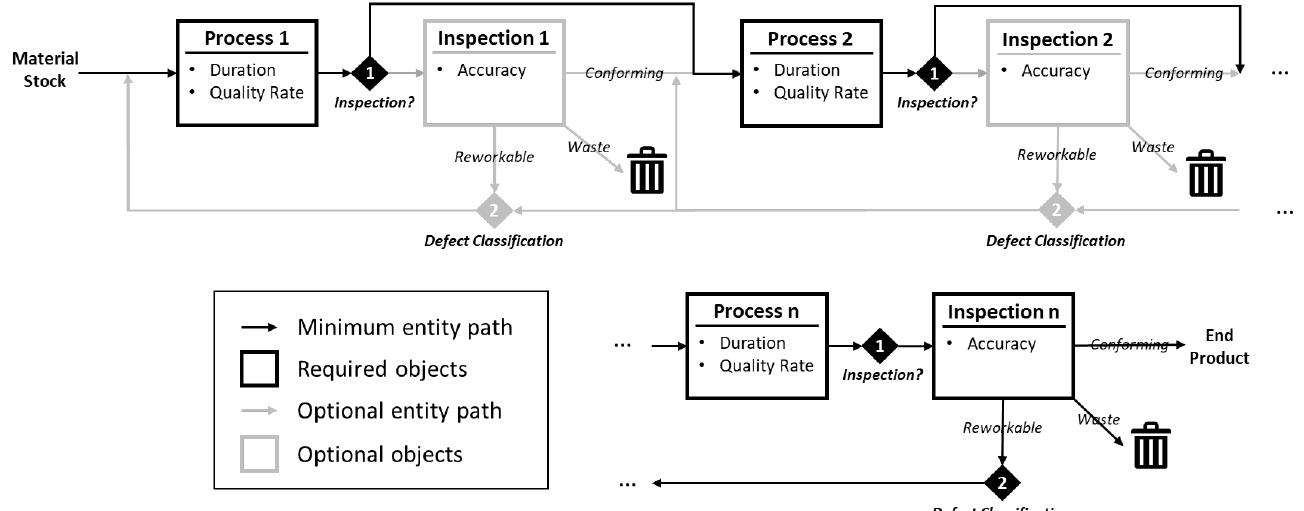
Figure 2. Architecture of the DES model proposed for inspection processes in a multistage manufacturing system.